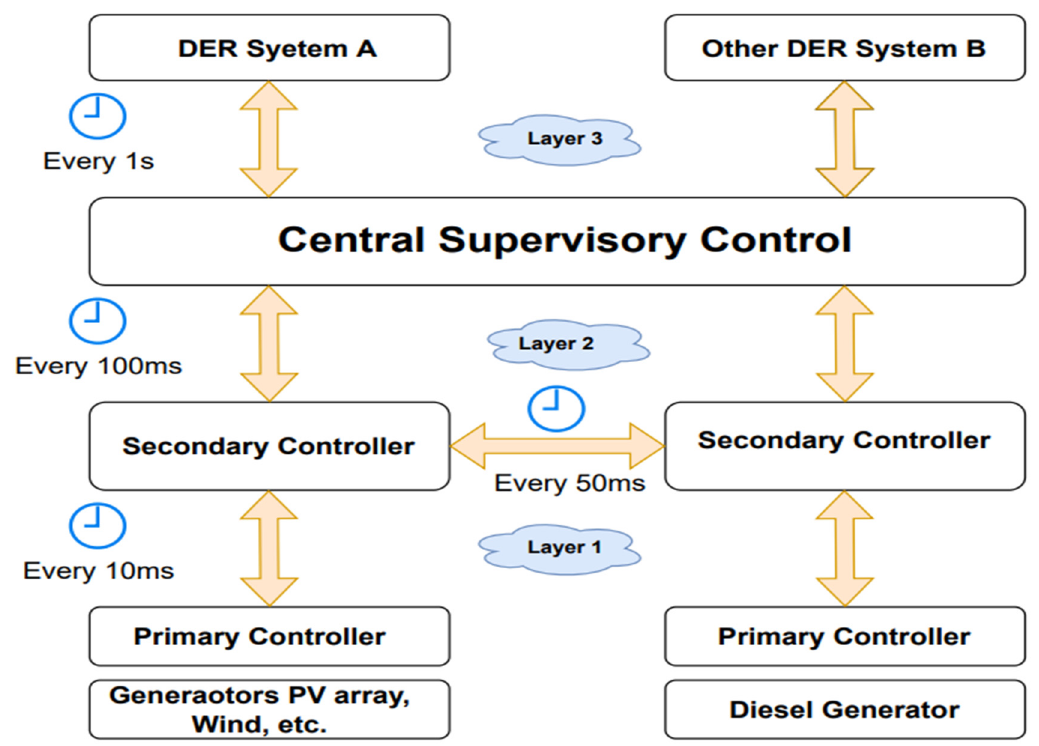
Figure 1. Distributed energy resources communication